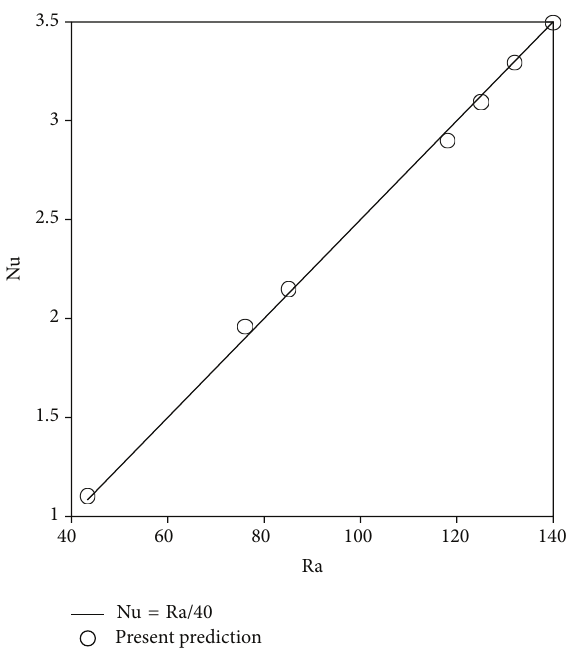
Figure 3: Nusselt number versus CO 2 mass fraction for different 𝑇 ℎ and 𝑇 𝑐 combinations with Δ𝑇 = 85